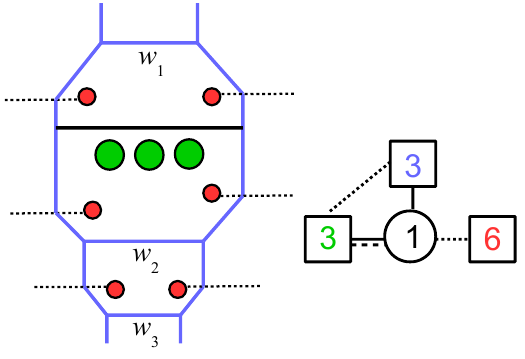
Figure 12 . Bubbling con(cid:12)guration for the dyonic loop L 1 ; 1 in the SU(3) N f = 6 theory.